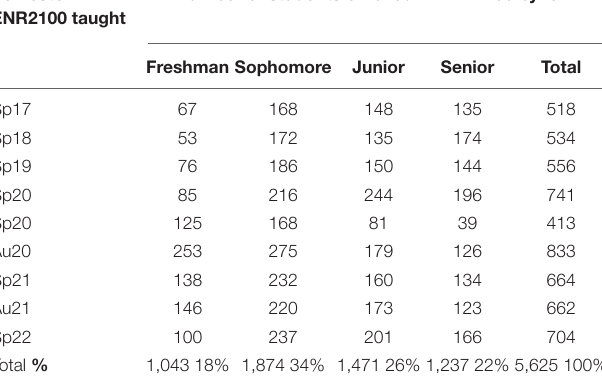
TABLE 1 | Student enrollment by class rank in ENR2100, introduction to environmental science. Semester ENR2100 taught